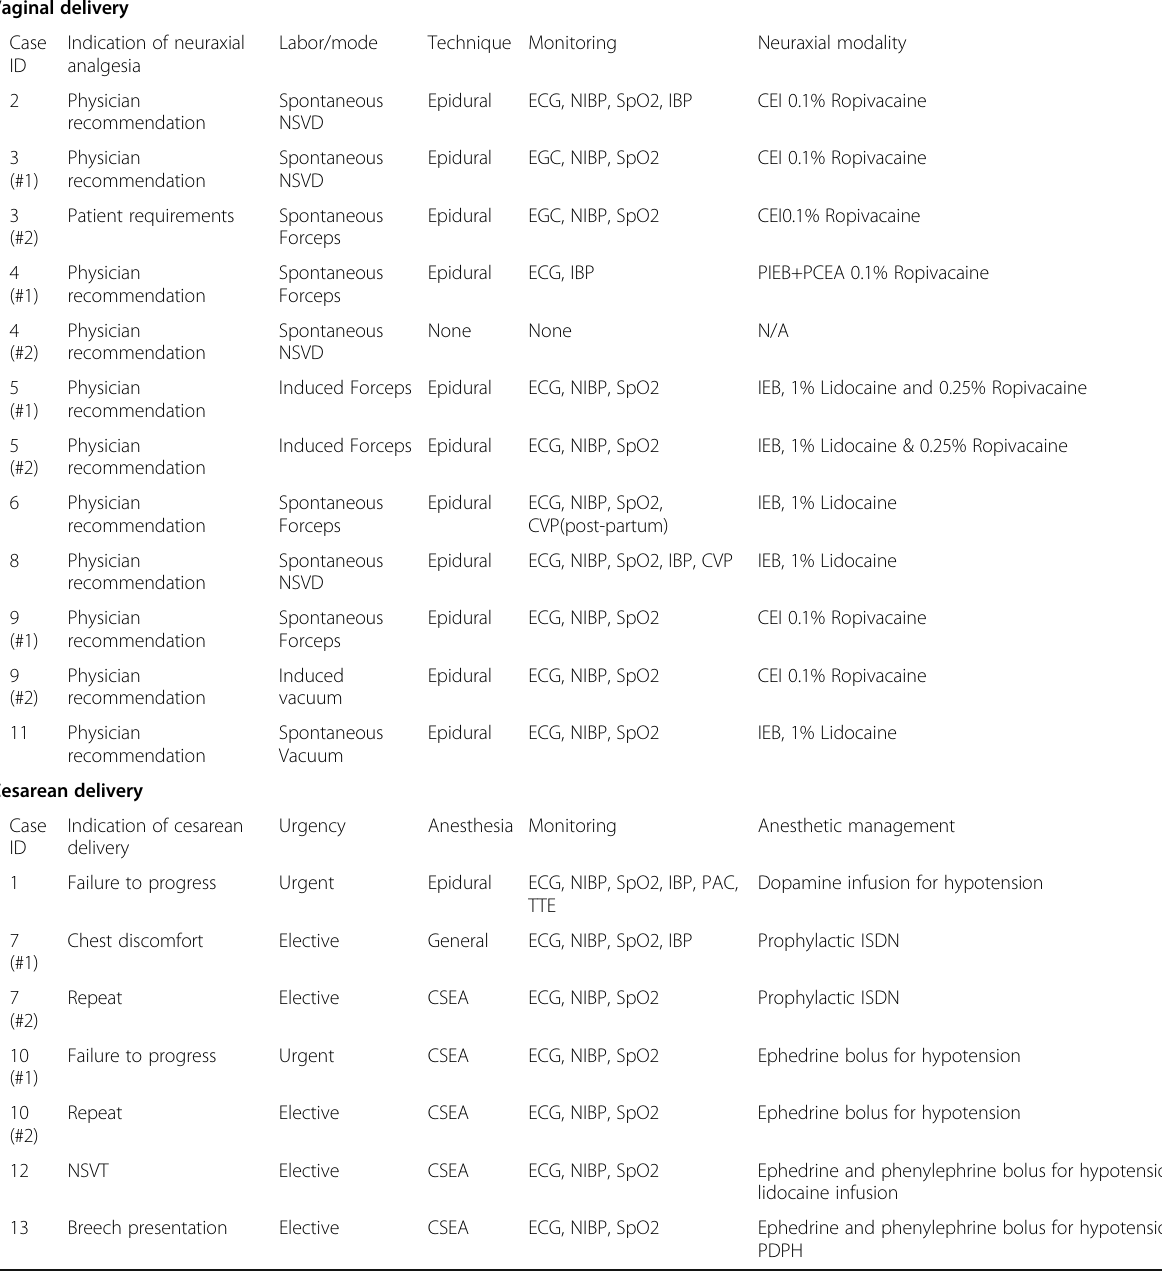
Table 2 Anesthetic and obstetric details Vaginal